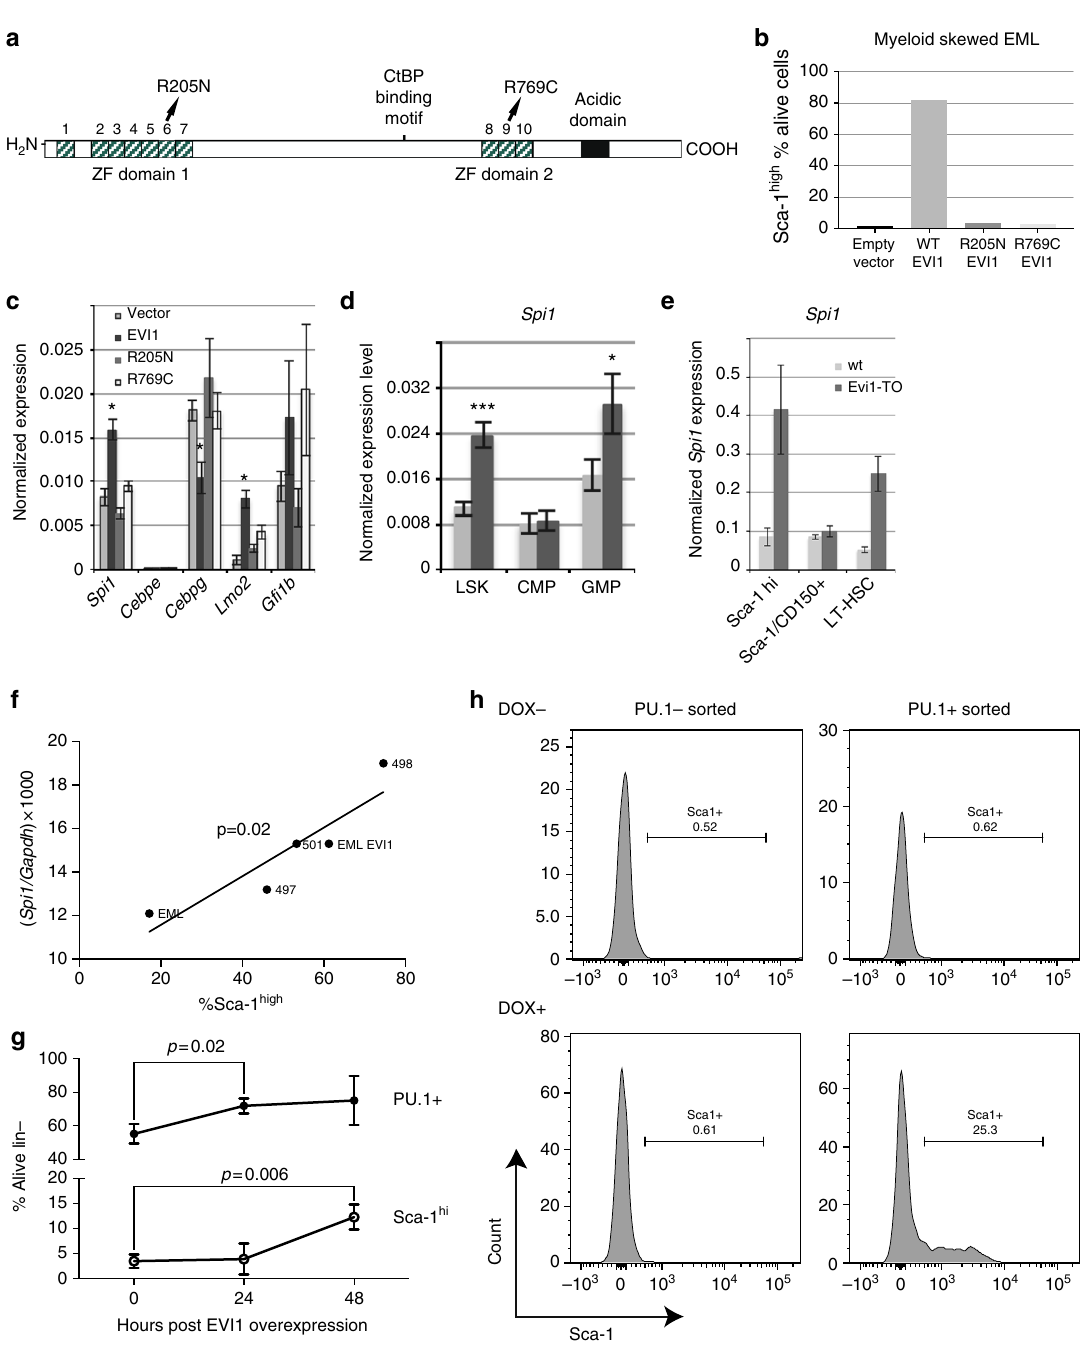
Fig. 6 EVI1-induced myeloid skewing: downstream effectors include PU.1. a Schematic of EVI1 protein domains, documenting the two zinc- fi nger domains and the location of the two arginine mutations that disrupt ZF1 and ZF2. b Flow cytometric quantitation of Sca-1 hi myeloid-skewed population in EML cells transduced with the indicated retroviral construct, designated on x axis. c RT-qPCR analysis of RNA from sorted Sca-1 hi EML cells transduced with the indicated constructs. Gene names are indicated on the x axis. All qPCR reactions performed in triplicate; displayed values represent the average. Errors bars represent standard deviation between qPCR reactions. * p < 0.005. d RT-qPCR data (normalized to Gapdh ) showing expression of Spi1 in progenitor populations from Evi1 TO/TO R26r tTA/rtTA CD45.2 donor compartments at 10 weeks of induction. e RT-qPCR data (normalized to Gapdh ) for Spi1 expression in sorted bone marrow progenitor populations from either WT mice or Evi1 TO , R26 rtTA mice (as indicated) treated with DOX for 72 hrs. f Scatterplot comparing Spi1 mRNA expression ( y axis) to percent Sca-1 hi cells ( x axis) for fi ve EML cell populations: unmanipulated EMLs ( “ EML ” ); EVI1-overexpressing EMLs ( “ EML EVI1 ” ), and three derivatives of the latter, transduced with either a Spi1 -speci fi c shRNA (497, 501) or a control shRNA (498). The p value is calculated using linear regression analysis. g Flow cytometric analysis for Sca-1 and PU.1 (GFP + ; top, percent positive) and Sca-1 (bottom; percent positive) on lineage-subpopulation within WBM harvested from Evi1 TO/TO , Rosa26 rtTA/rtTA , Spi1 GFP/GFP mice at 0, 24, or 48 h after DOX induction (0 h n = 3, 24 h n = 3, 48 h n = 3). h Flow cytometric analysis for Sca-1 in Lin-Sca-1-cKit-PU.1GFP-sorted (left two histograms), or Lin-Sca-1-cKit-PU.1GFP + sorted (right